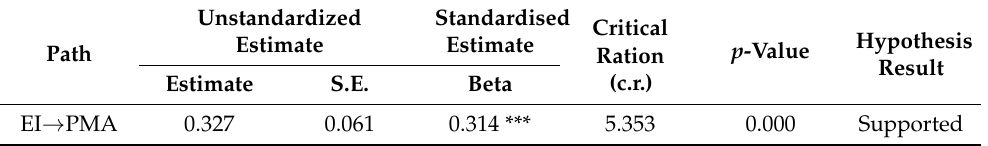
Table 5. Examining Results of Direct Effects of the Constructs by